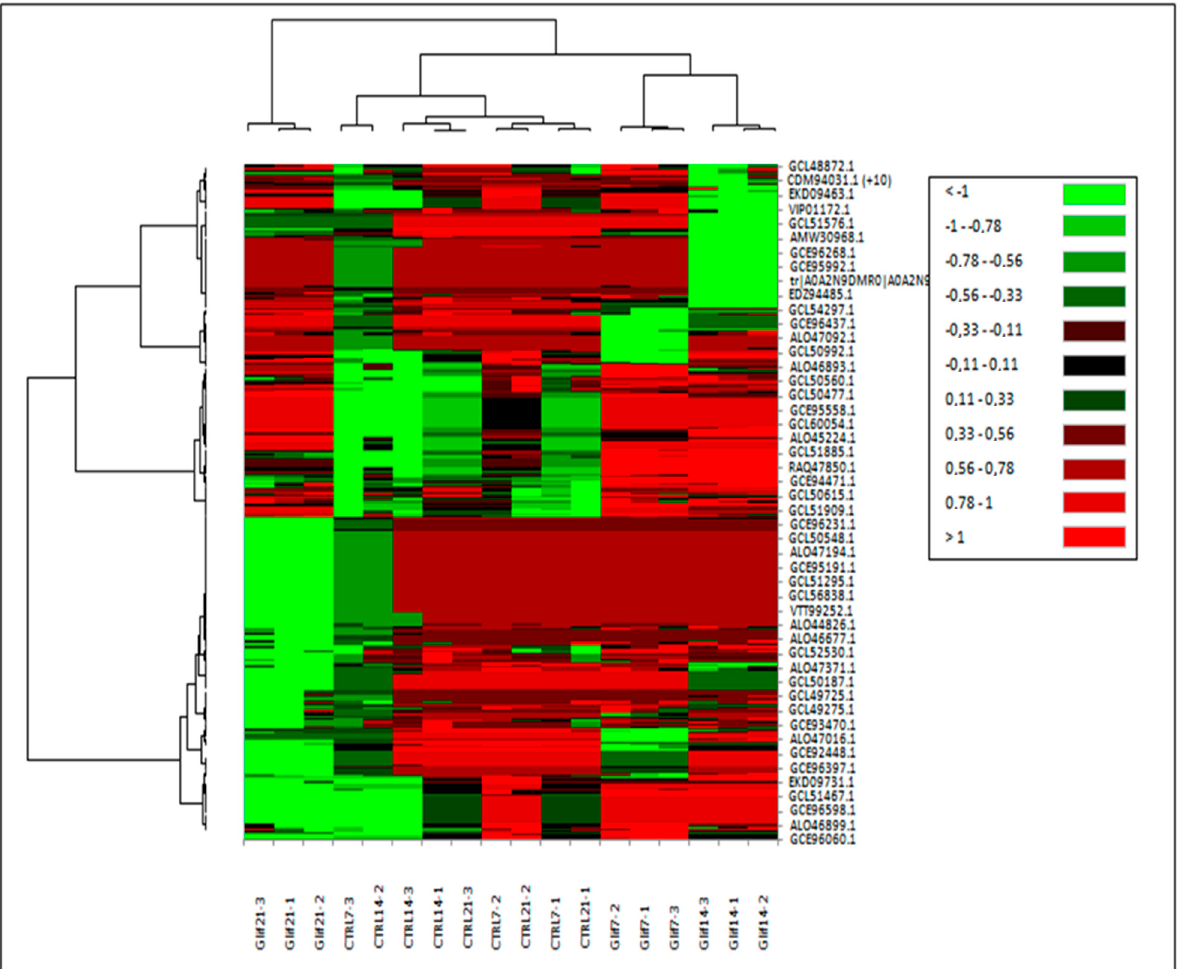
Figure 10. Heat map of proteins differentially expressed in A. maxima samples treated with 0.2 mM glyphosate compared to reference samples at various sampling times. Protein expression values were normalized to log2 and cluster analysis was performed using FC levels for proteins with p < 0.05. Red indicated a high level of expression; green indicated a low level of expression (XLSTAT 2021.3.1.1187- Heat maps features). The details of the analysis are shown in Supplementary Table S4.